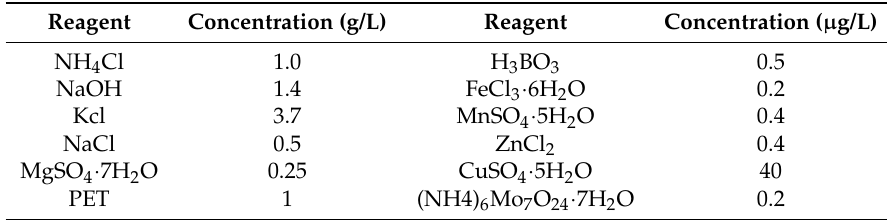
Table 2. Culture composition of bacteria